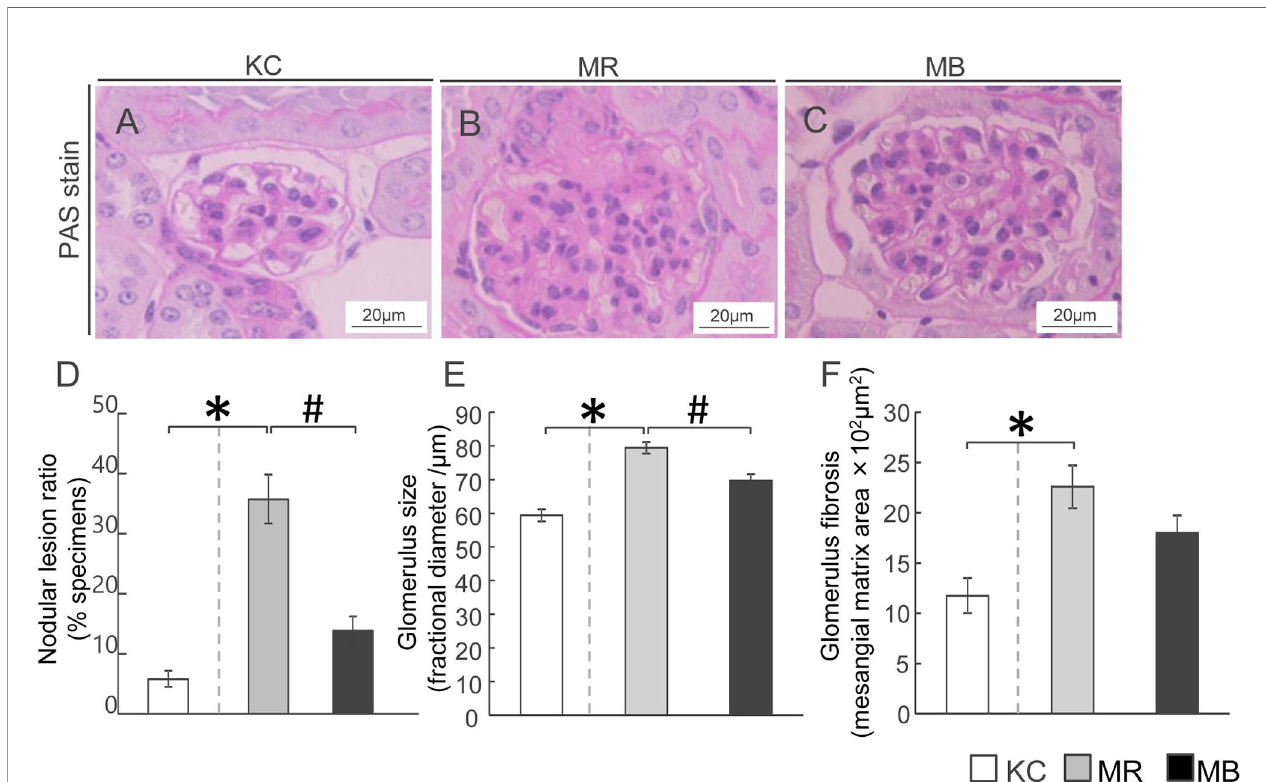
FIGURE 2 | Histopathology showing fi brosis and pathogenesis in the kidneys of mice after 10 weeks of experimental diet intake. (A – C) Glomerular fi brosis observed using Periodic acid – Schiff staining (scale bar, 20µm) in mice from the three groups. (D – F) Quanti fi cation of the nodular lesion ratio (D) , glomerular size (E) , and fi brotic area (F) . MB, minimum essential medium (MEM) mice on a barley diet; MR, MEM mice on a rice diet; KC, potassium simplex optimized medium control mice on a rice diet. Data are expressed as the mean ± SEM for 8 – 12 animals. Data were analyzed using Student ’ s t -test. * P < 0.05 compared with the KC group; # P < 0.05 compared with the MR